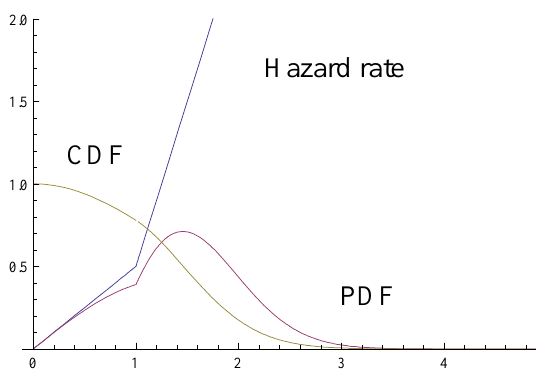
Figure A2. The distribution of estimated changepoint based on 1000 Monte Carlo